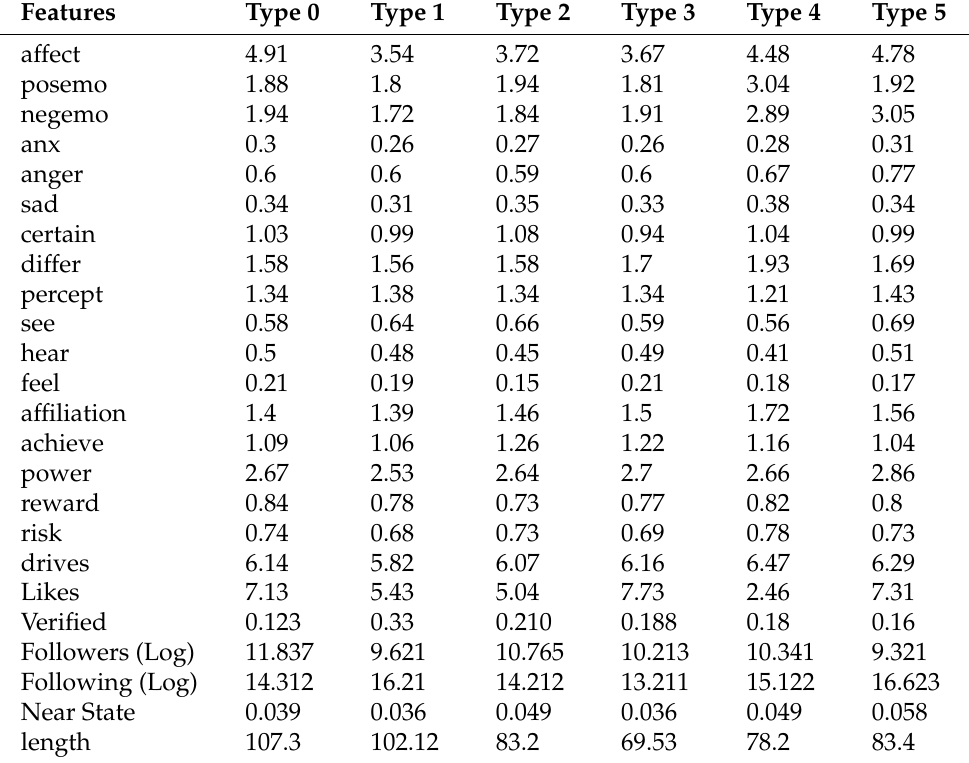
Table 4. Full Summary of Attributes (features) of each Type of Situational Information.